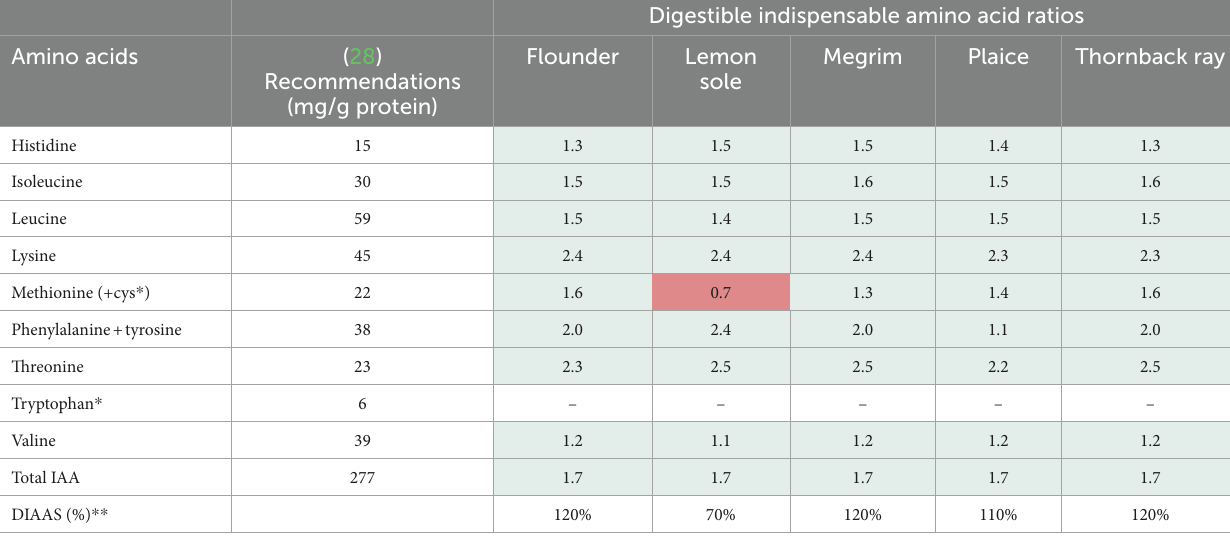
TABLE 3 Average total digestible indispensable amino acid ratios and scores (DIAAS) for central fillets of flounder, lemon sole, megrim, plaice, and thornback ray based on recommendations for adults set by FAO et al.